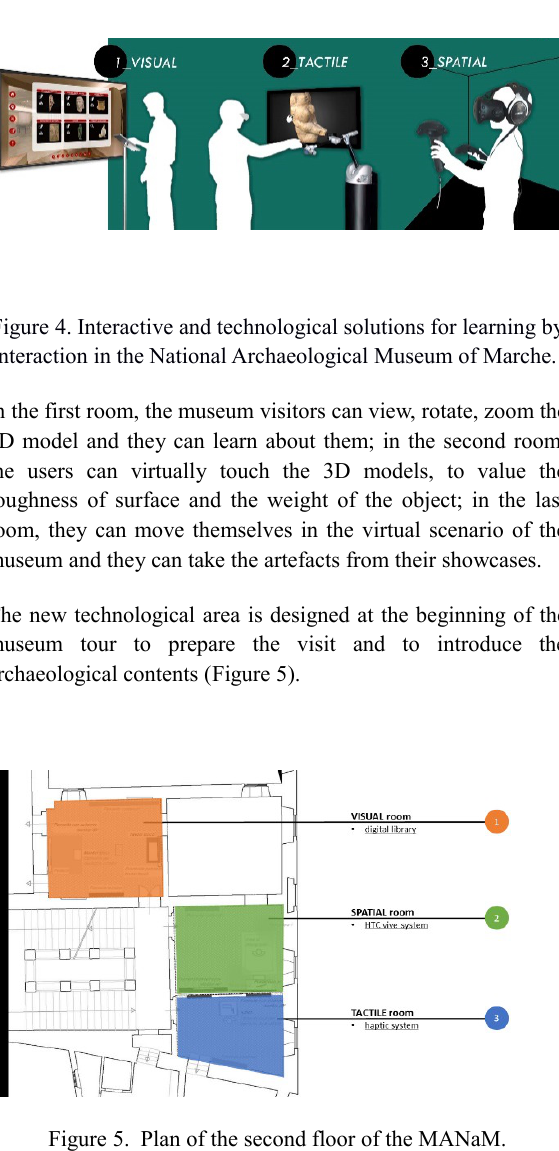
Figure 5. Plan of the second floor of the MANaM.